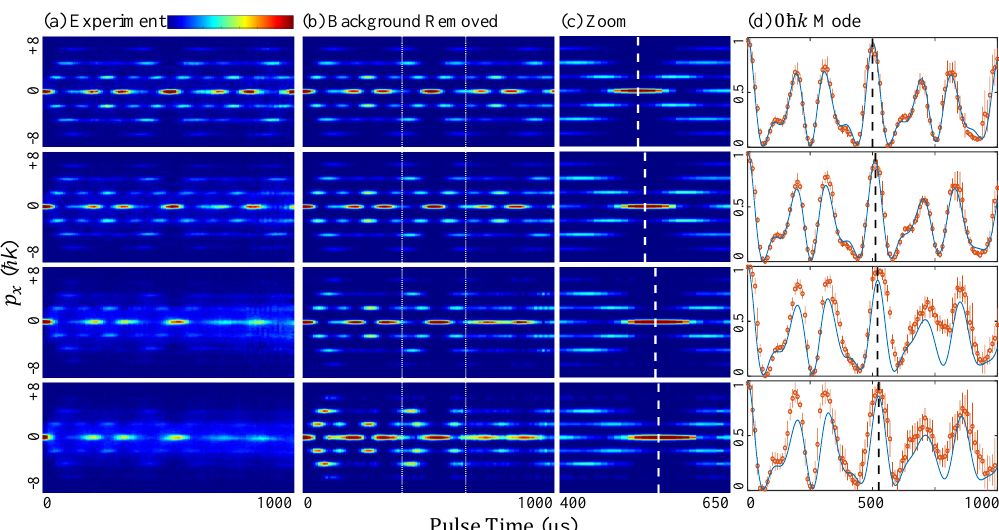
= 50 E Figure 4: (a) Time carpets measured with U for different interaction r 0 strengths. (b) The momentum modes with background removed and normalized to the total condensate number at each time. The vertical dash lines mark the zoom in range for (c) . (d) The corresponding normalized populations of the 0 ħ hk mo- mentum mode (circle), shown in each case with the 1D GPE simulation result (solid line). The error bars for the population show the standard deviation of the fit results from 10 measurements. The simulation curves were produced with mean field in- teraction, including a phenomenological scaling factor η = 4.2 common to all case to take into account the additional interaction energy, as explained in the text. The vertical dashed lines in (c) and (d) indicate the time point at which the coherent pop- ulation is restored to the 0 ħ hk mode (recurrence of the mBEC). The shift of the peak clearly shows the slowing down of the scattering process under stronger interactions. Interaction-dependent loss leads to degradation of contrast of the scattering patterns, and also results in deviations of population ratios from theoretical results (see text = 2526 a in Section 4.2). For a at long pulse times ( t > ∼ 600 µ s ), the images ac- dd 0 quired have poor signal-to-noise ratio and population determination by fitting gives rather unclear